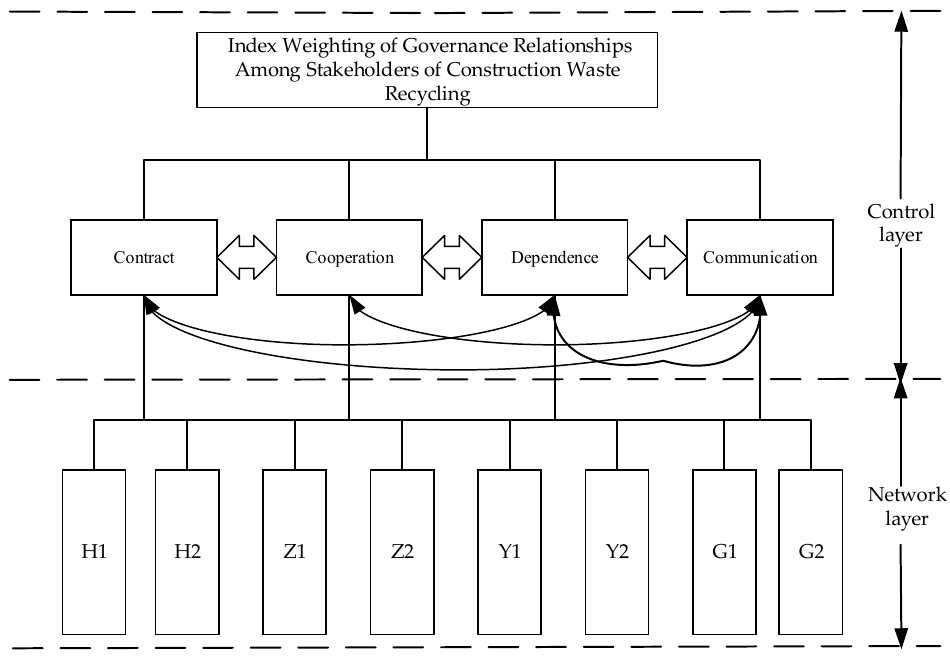
Figure 1. ANP model of governance relationships among stakeholders.